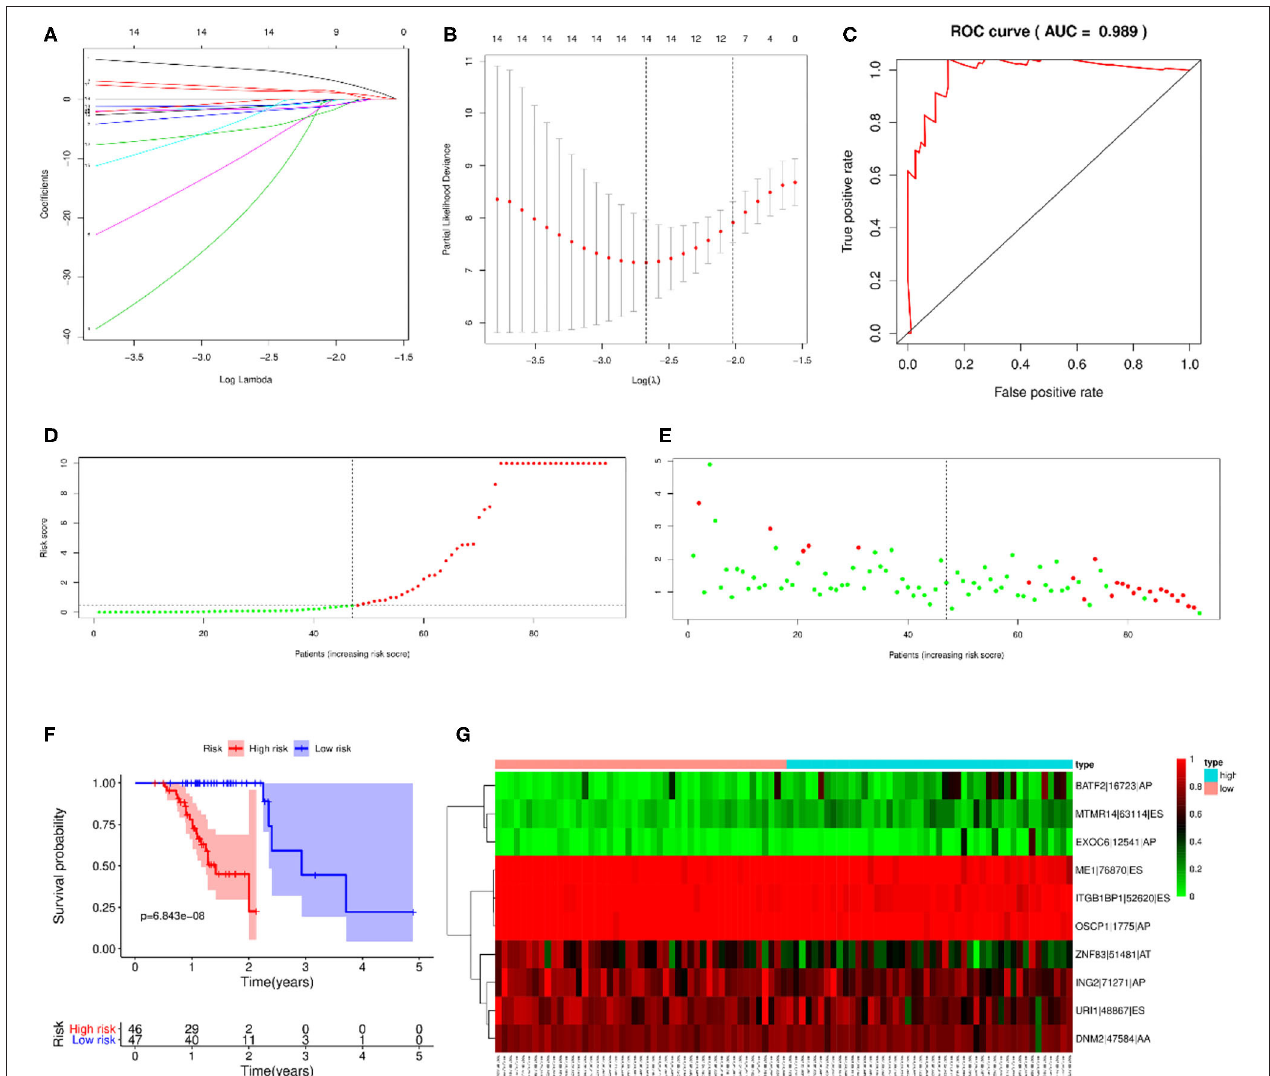
FIGURE 8 | Prognostic model based on all types of OS-ASEs. (A) Cross-validation for tuning parameter selection in the proportional hazard model. (B) LASSO regression analysis for screening coefficients in all types of OS-ASEs. (C) The ROC curves for evaluating the efficiency of the prognostic model. (D) The risk curve of 93 SKCM patients matched with intact follow-up data. (E) The scatter plots of SKCM samples. The red and green plots represent alive and death endpoints, respectively. (F) Kaplan–Meier overall survival curves based on all types of OS-ASEs. The numbers of patients in the high-risk and low-risk groups at different survival times are listed at the bottom panel, respectively. (G) The heatmap of 10 OS-ASEs selected by LASSO regression analysis.